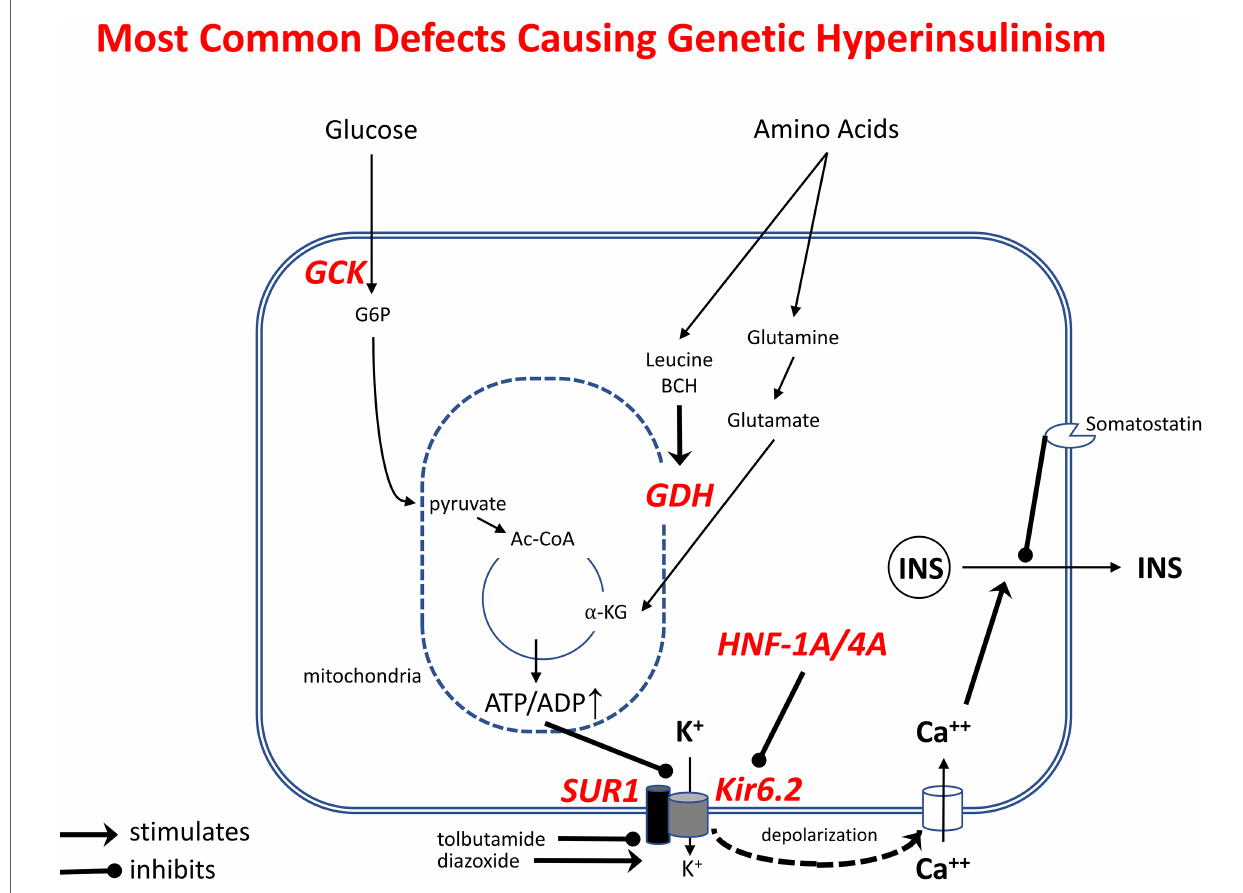
FIGURE 4 Most common genetic defects causing Genetic Hyperinsulinism. Outlined are the pathways stimulating beta-cell insulin release by glucose and amino acids. Oxidation of these fuels in mitochondria increases ATP/ADP ratio, leading to inhibition of K + ef fl ux via plasma membrane ATP-sensitive KATP-channel, membrane depolarization, Ca ++ in fl ux, and release of insulin from storage granules. Tolbutamide stimulates insulin release by closing K ATP -channels; diazoxide inhibits insulin release by opening K ATP -channels. Genetic Hyperinsulinism can be caused by inactivating mutations of K ATP - channel subunits (SUR1 or Kir6.2, encoded by ABCC8 and KCNJ11 ) and by activating mutations of glucokinase (GCK) or glutamate dehydrogenase (GDH, encoded by GLUD1 ); inactivating mutations of HNF1A or HNF4A cause hyperinsulinism by decreasing gene expression of K ATP -channel